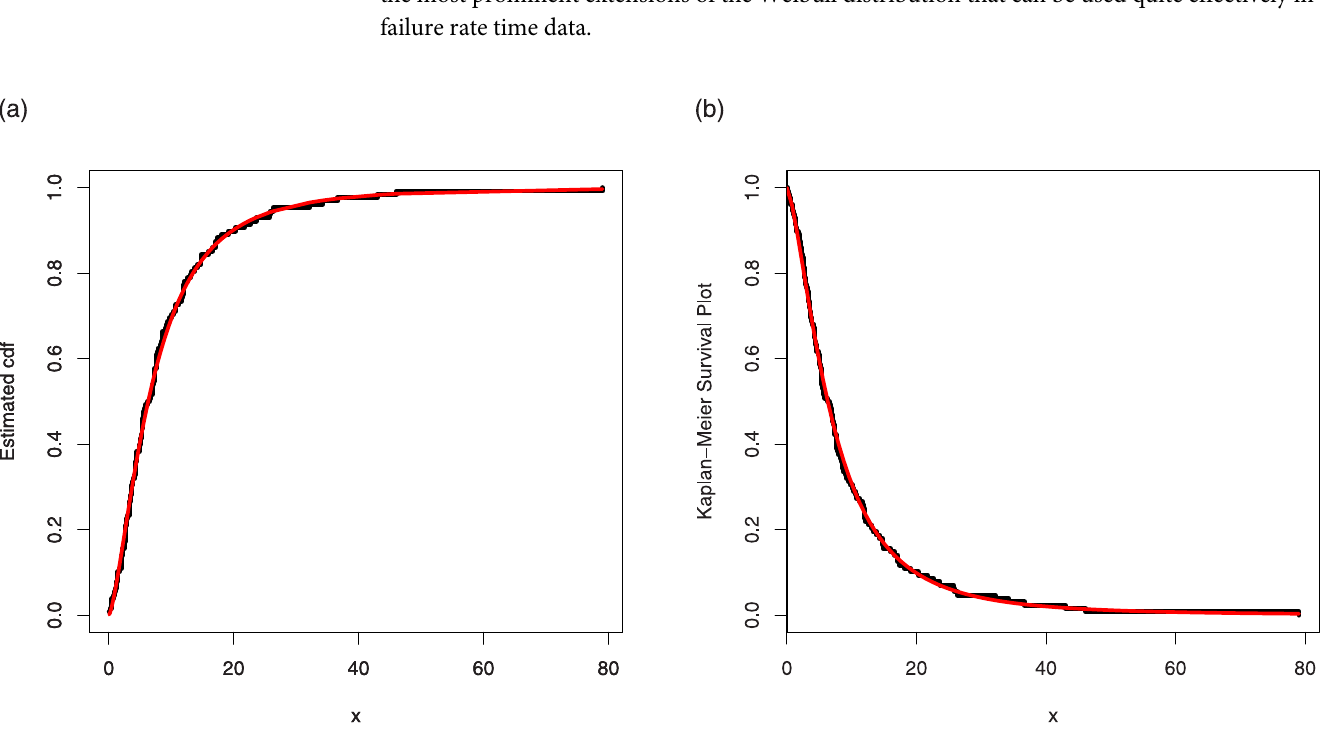
Fig 7. Estimated cdf and Kaplan Meier survival plots of the TI-HTW distribution for data 1.